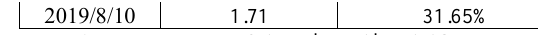
Table 2 . Results of box plot for all roads in rainfall events